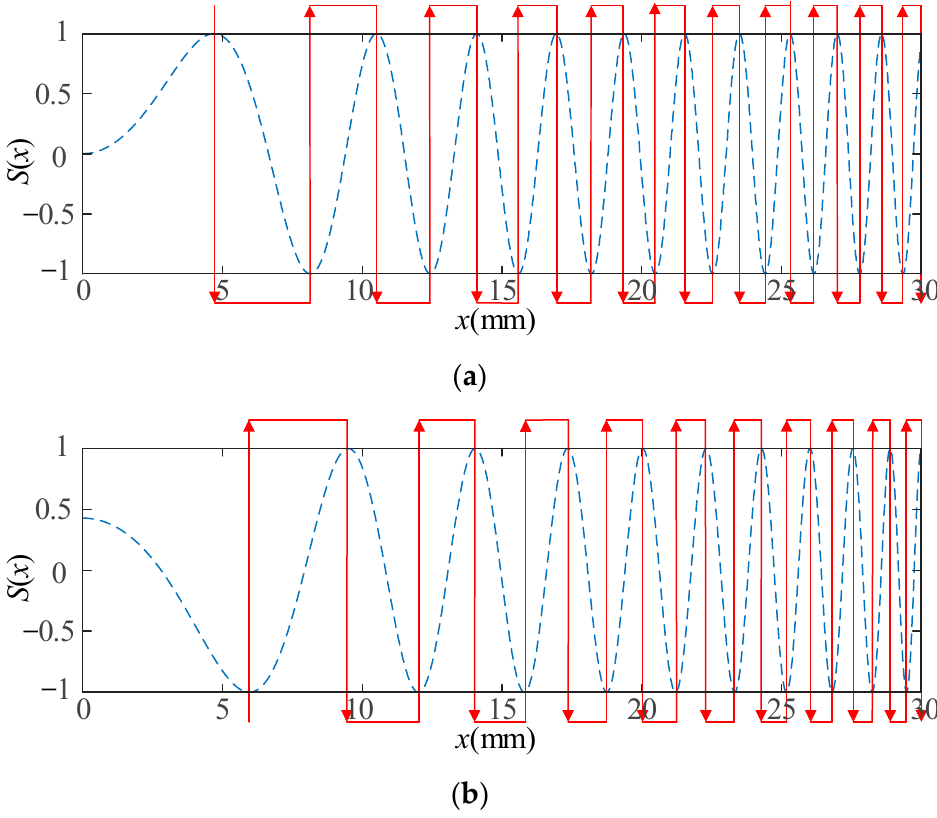
Figure 5. LWM and NLWM coil geometries for an aluminum sample: ( a ) LWM ( k 0 = 0 mm − 1 , K = 0.68 mm − 1 , L = 30 mm); ( b ) NLWM ( K = 2 mm − 1 , L = 30 mm).